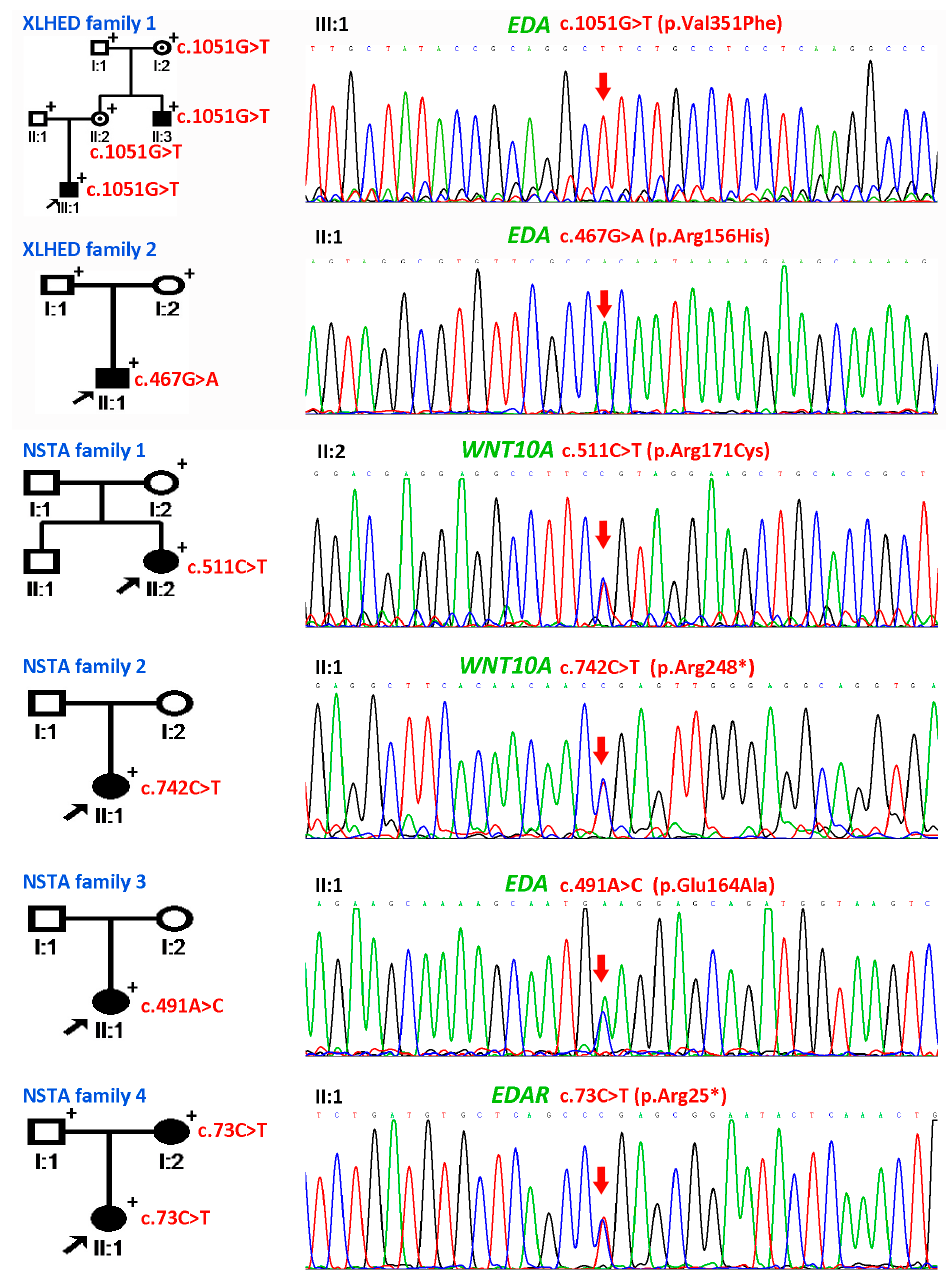
Figure 2. Pedigrees and mutation information of X-linked hypohidrotic ectodermal dysplasia (XLHED) Families 1–2 and non-syndromic tooth agenesis (NSTA) Families 1–4. In XLHED Family 1, a